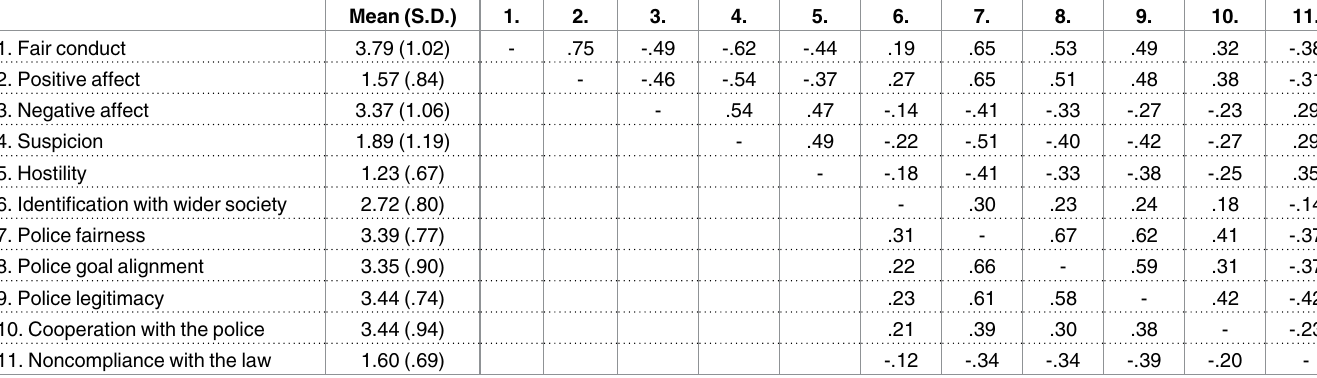
Table 1. Descriptivestatistics and correlations for main variables of interest.